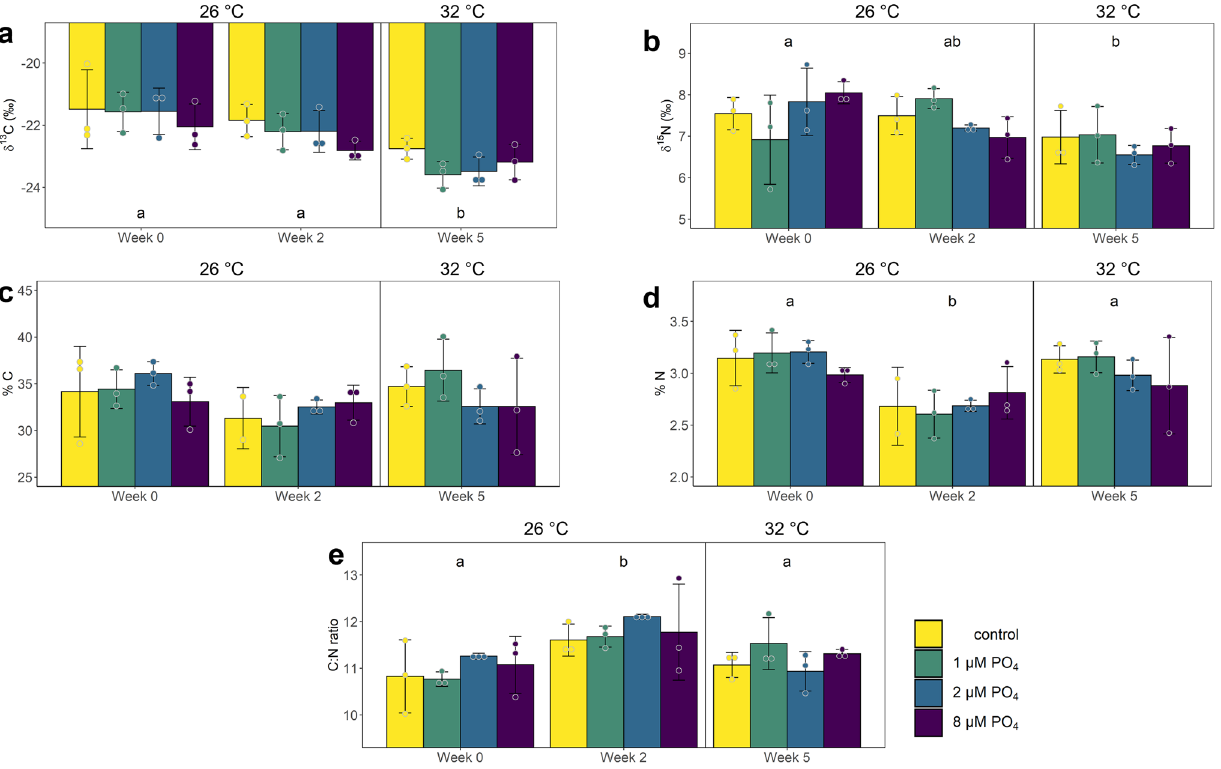
Figure 4. Carbon ( a ), and Nitrogen ( b ) stable isotope ratio, percent carbon ( c ), percent nitrogen ( d ), and carbon to nitrogen ratio ( e ) of Xenia umbellata colonies under experimental phosphate conditions: only temperature increase without PO 4 addition (control), 1 µM PO 4 + temperature increased from week 3 onwards (1 µM PO 4 ), 2 µM PO 4 + temperature increased (2 µM PO 4 ), and 8 µM PO 4 + temperature increased (8 µM PO 4 ). Letters indicate significant differences between weeks (p < 0.05, pairwise comparison t-test, Bonferroni adjustment). Error bars represent standard errors. Dots represent the individually measured data points. The vertical line indicates the start of the temperature treatment and the average temperature for all tanks for the different time points is given on top of the